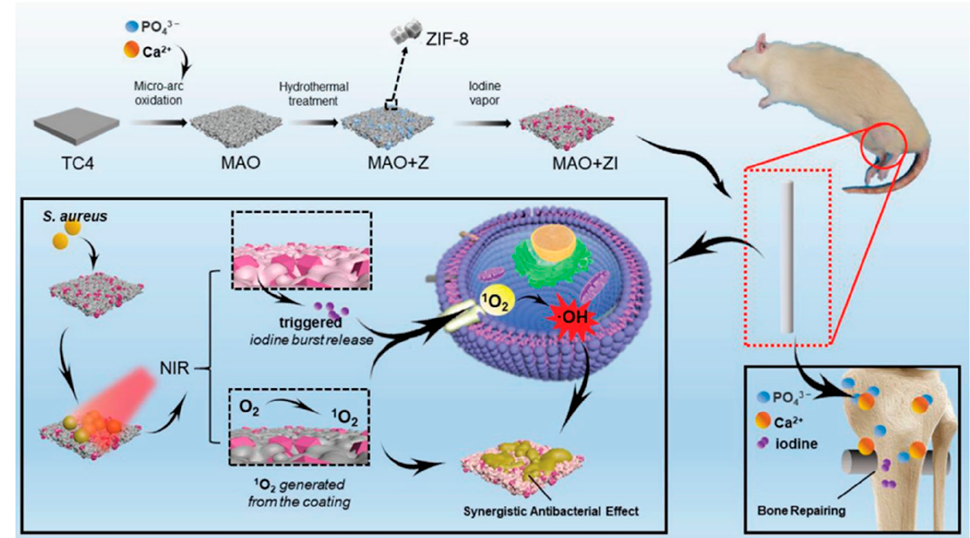
Figure 7. Schematic illustration of the synthesis process, hierarchical structure of MAO+ZI coating system, the antibacterial process ( S. aureus ) guided by NIR-triggered iodine burst release combined with one O 2 generated from the surface, and effective osseointegration enhanced by the Ca 2+ , PO 4 3 − and iodine in vitro and in vivo. Reproduced with permission from [70].